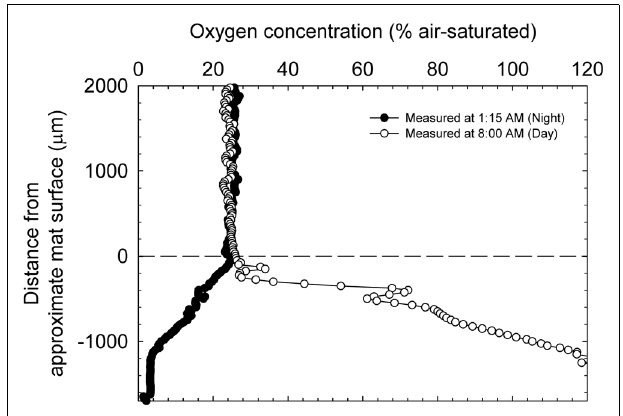
FIGURE 4 | Dissolved oxygen depth profiles entering the upper strata of the explanted microbial mats at two time points during a diel cycle.